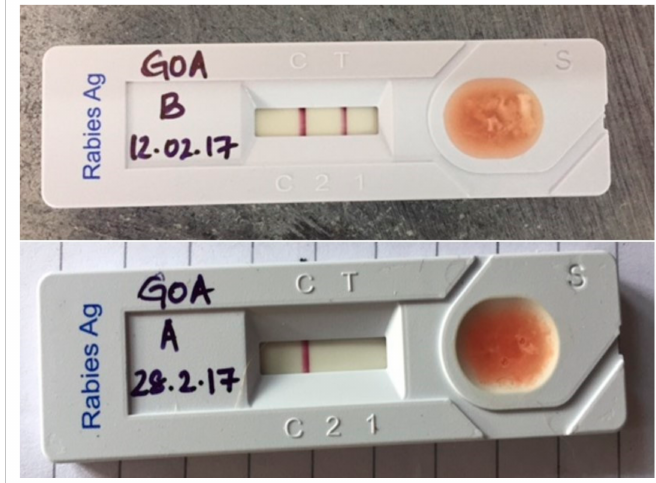
Figure 1. Flow immunochromatographic assay (LFA) showing a positive result ( top ) and a negative result ( bottom